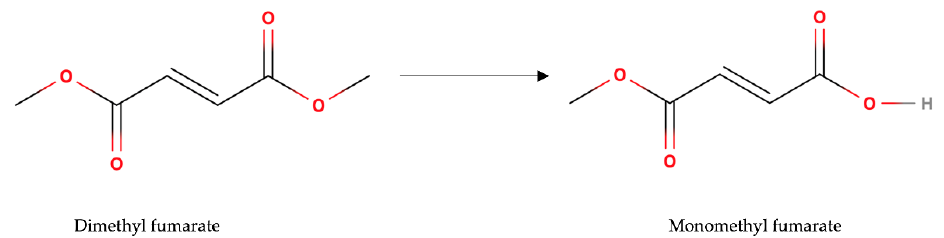
Figure 1. Pre-systemic metabolism of dimethyl fumarate to monomethyl fumarate by